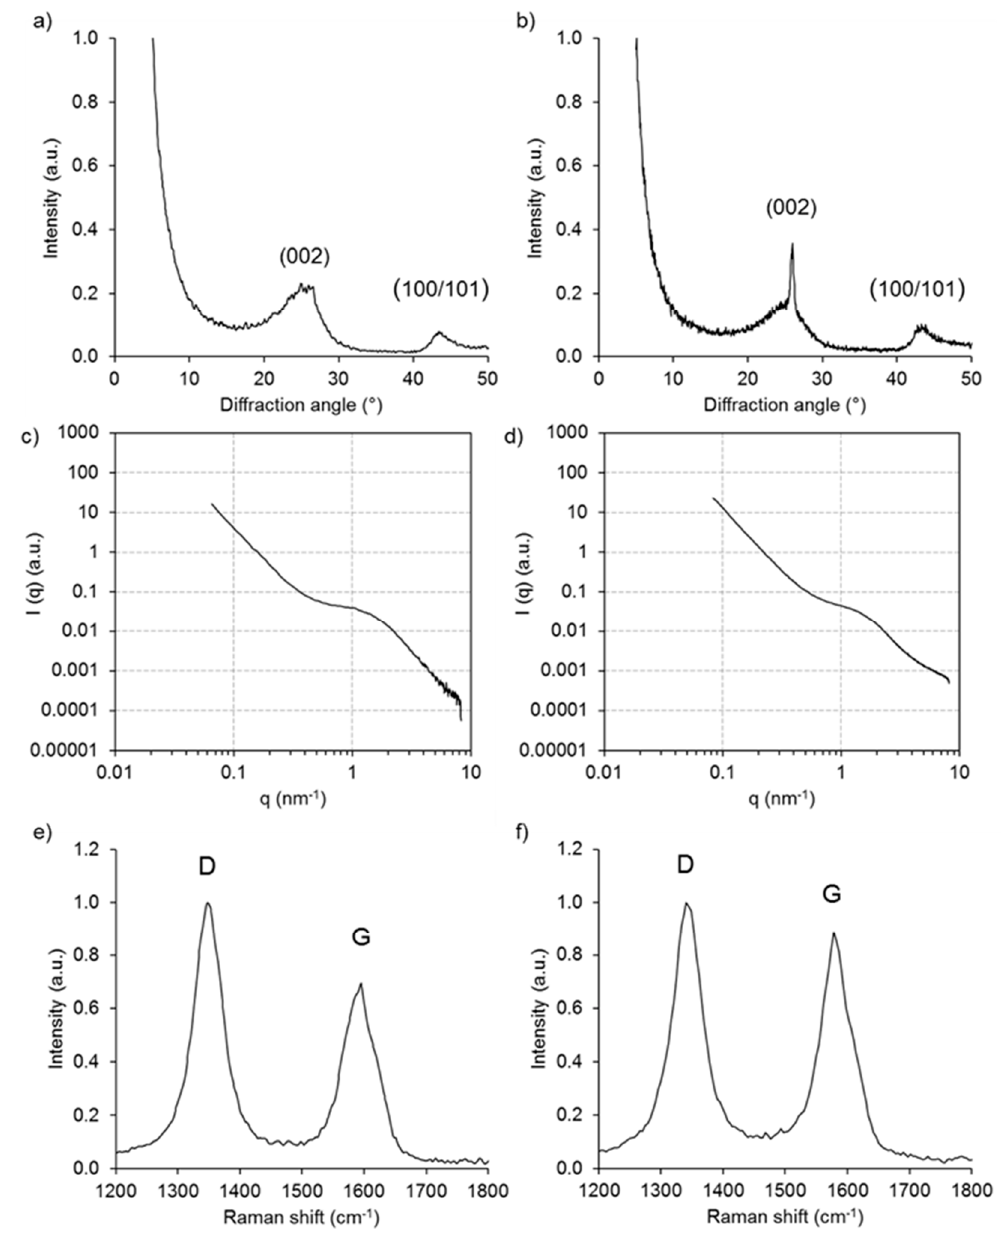
Figure 2. X-ray diffraction ( a , b ), small angle X-ray scattering ( c , d ), and Raman spectroscopy ( e , f ) of carbon particles derived from Indulin AT ( a , c , e ) and sub-micron lignin particles ( b , d , f ).